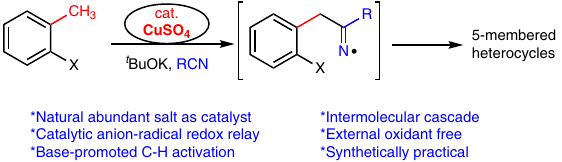
Fig. 1 Formation of iminyl radical from anion/radical redox relay other than N-O cleavage or initiators. a Base-promoted benzylic C-H cleavage in the absence of transition metal catalysts followed by an addition to alkenes.